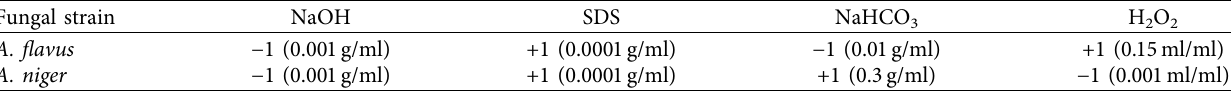
Table 1: The optimal experimental design for ghost cells preparation from each fungus including four chemicals variables in +1 or − 1 level. Fungal